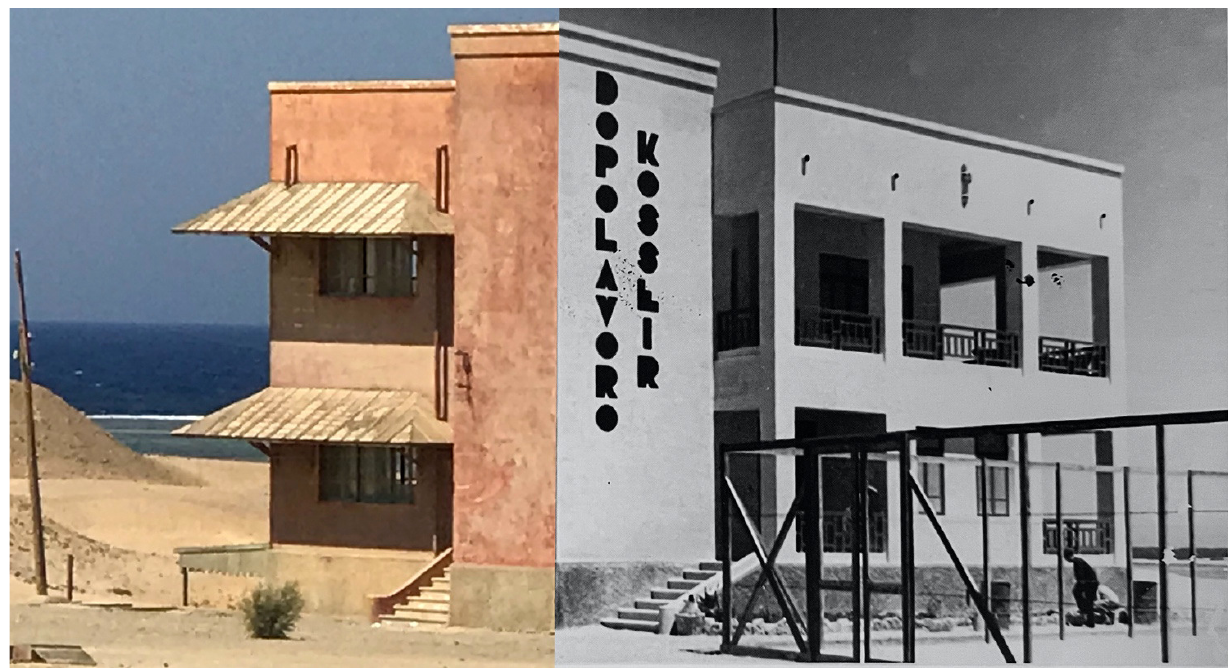
Figure 9. The cafeteria inside the coastal plant, where most scenes of the 2022 movie El‐Gareema were filmed (left); the building was originally built as a restaurant, where Italians and Egyptians used to gather during lunchtime (right). Sources: Project fieldwork (2022; left) and Pellegrini (2011, p. 187;